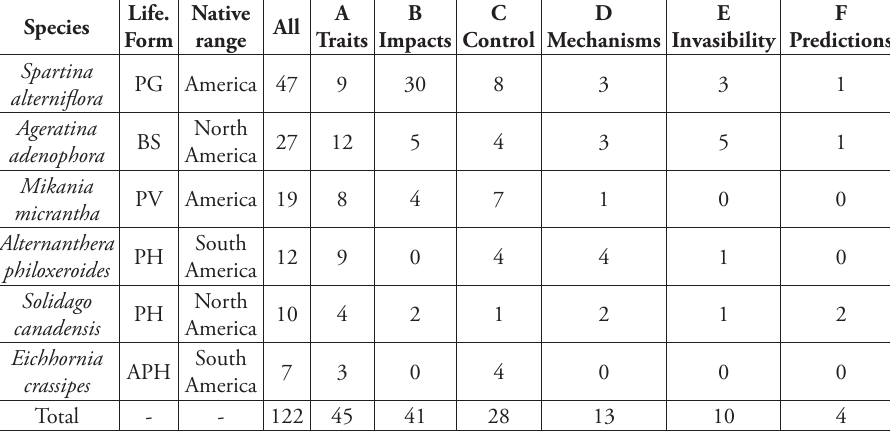
table 2. Most-studied alien plant species in China and related research topics (number of studies refer- enced in the ISI Web of Knowledge, 2001–2010). The native range and life form of the species are also shown. PG – perennial grass; BS – broadleaf shrub; PV – perennial vine; H – perennial herb; APH – aquatic perennial herb. The codes for the research topics A–F are the same as in Table 1. Species